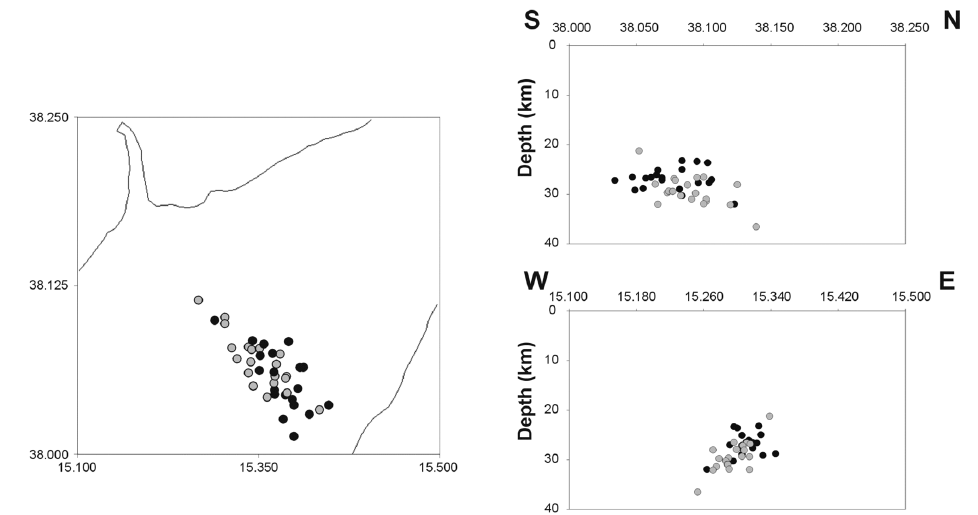
Fig. 6. Cluster 3 – Seismic swarm of the Nebrodi-Peloritani system. Grey circles represent the located events us- ing the land-stations; black circles are the integrated locations. On the right, S-N and W-E sections are